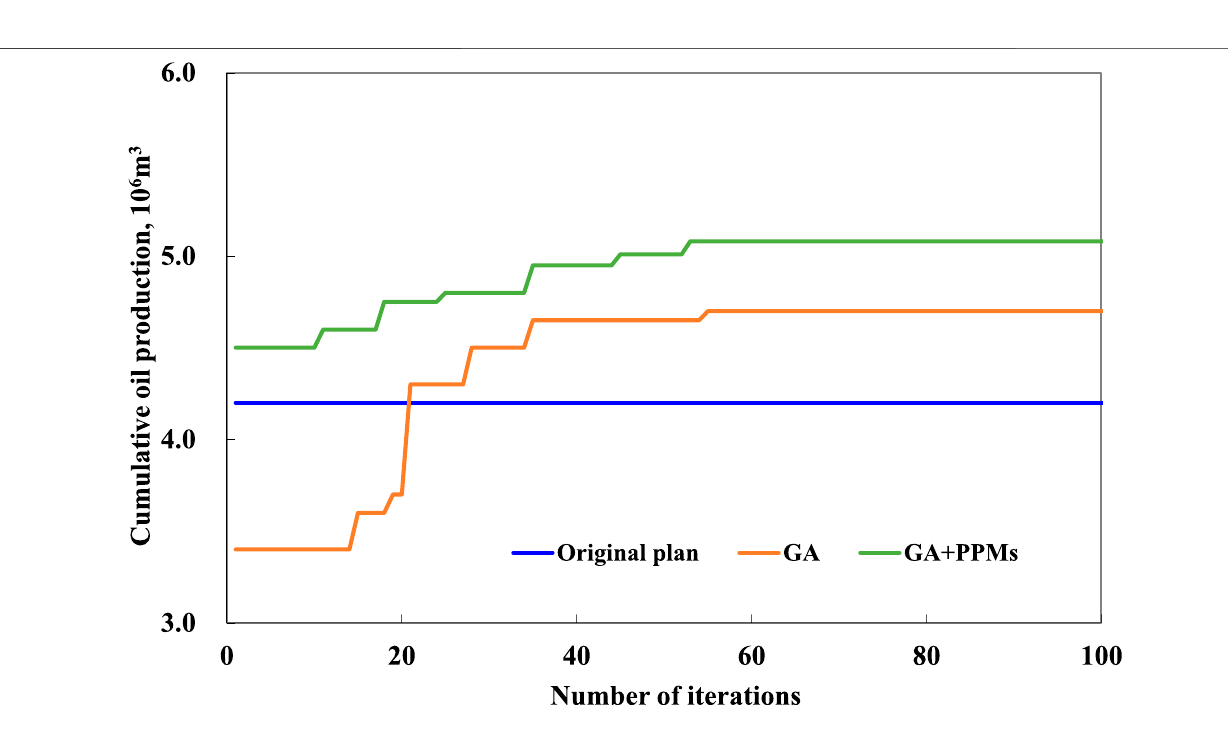
Figure 7 is a statistical histogram of cumulative production proposed by the three methods and original well placement.